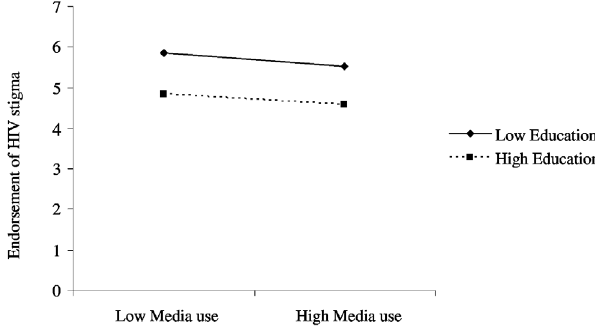
Figure 4. Regression plot for the interaction between media use and